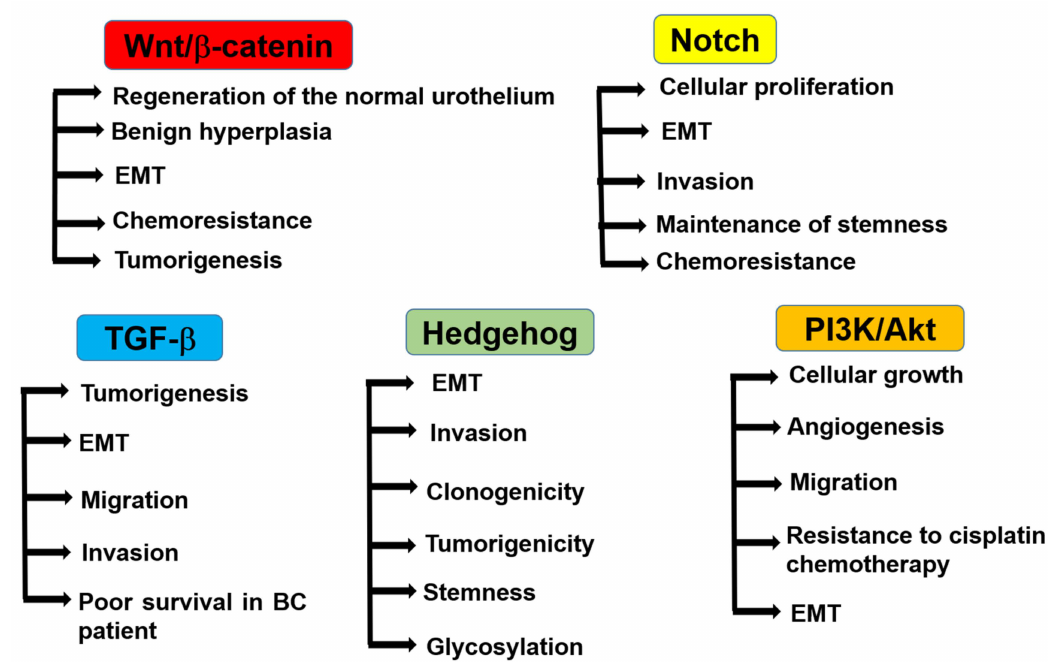
Figure 2. Regulatory pathways of bladder CSCs. Wnt / β -catenin signaling promotes the regeneration of the normal urothelium and benign hyperplasia in normal bladder tissues. In BC, it regulates EMT, chemoresistance, and tumorigenesis. Notch signaling regulates cellular proliferation, EMT, cell invasion, stemness, and chemoresistance in BC. TGF- β signaling regulates tumorigenesis, EMT, and cell migration and invasion in BC. The activation of TGF- β signaling is correlated with poor survival in BC patients. Hedgehog signaling regulates EMT, invasion, clonogenicity, tumorigenicity, stemness, and glycosylation. PI3K / Akt signaling regulates cellular growth, angiogenesis, migration, resistance to cisplatin chemotherapy, and